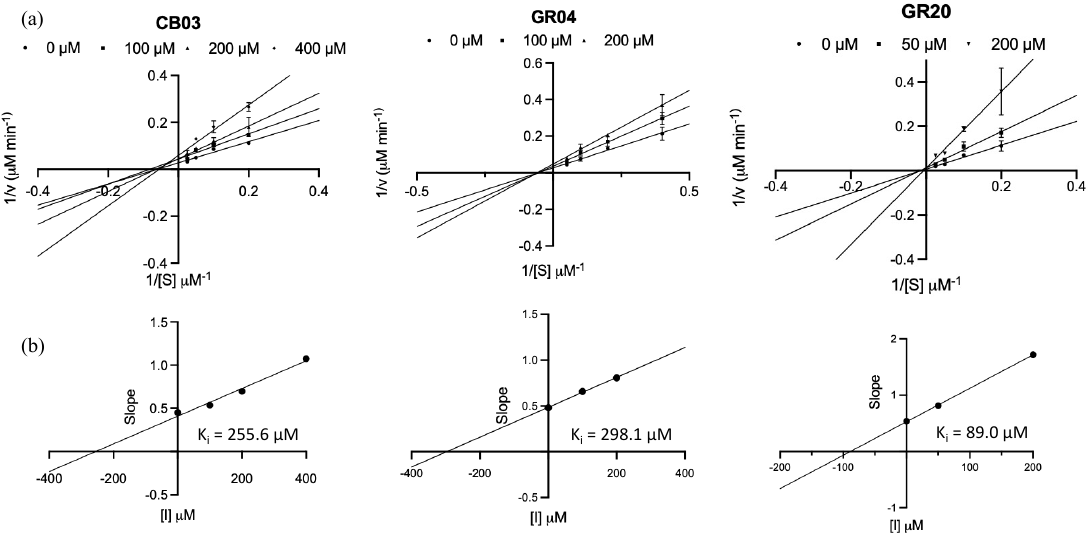
Figure 2. ( a ) The Lineweaver–Burk plot (1/substrate concentration (1/[S]) vs. 1/velocity (1/V)) of CB03, GR04, and GR20, which show competitive, noncompetitive, and mixed inhibition mechanisms, respectively. ( b ) The inhibition constant plots (slope from Lineweaver–Burk linear curves vs. inhibitor concentration [I]) of CB03, GR04, and GR20, where the K i values = − y-intercept.